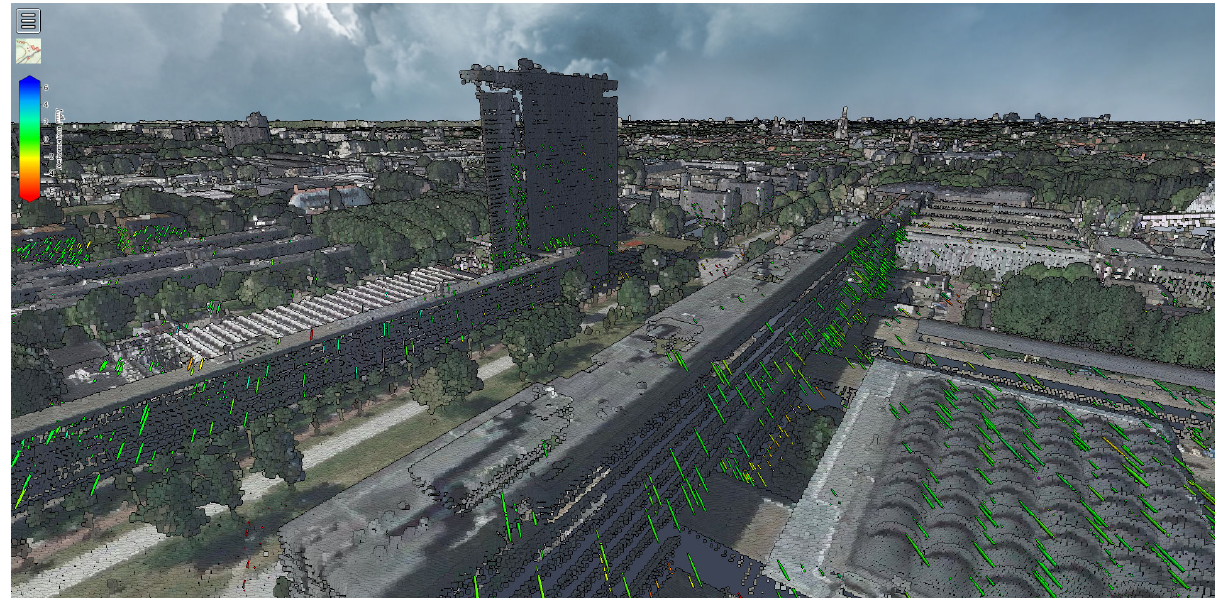
Figure 6. Delft University of Technology campus, shown using an adapted version of Potree, as a coloured point cloud (AHN3) overlaid with TerraSAR-X PS-InSAR trend estimates (shown as 1 σ error ellipsoids around the expected position, coloured by their deformation signal).